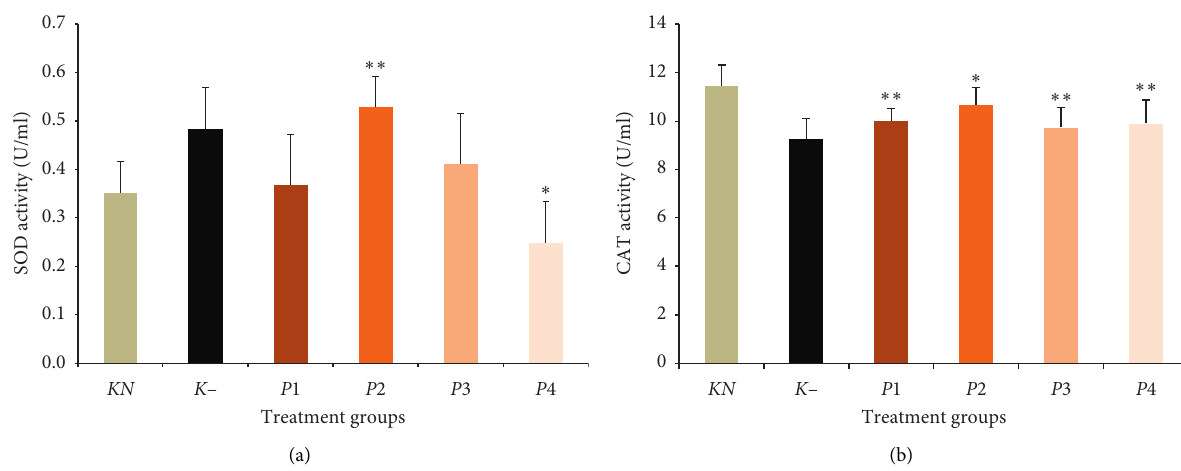
Figure 1: Effect of methanol extract of okra pods on both superoxide dismutase (SOD) and catalase (CAT) activity in lead acetate-induced mice. Values are as expressed as mean ± standard deviation ( n � 5). ∗ P < 0 . 05 shows significant differences in K − . ∗∗ P < 0 . 05 shows sig- nificant differences in KN , confidence interval 95%. KN : normal control, K − : negative control. P 1, P 2, P 3, and P 4 were treated with 50, 100, 200, and 400mg/kg BW methanol extract of okra pods, respectively.